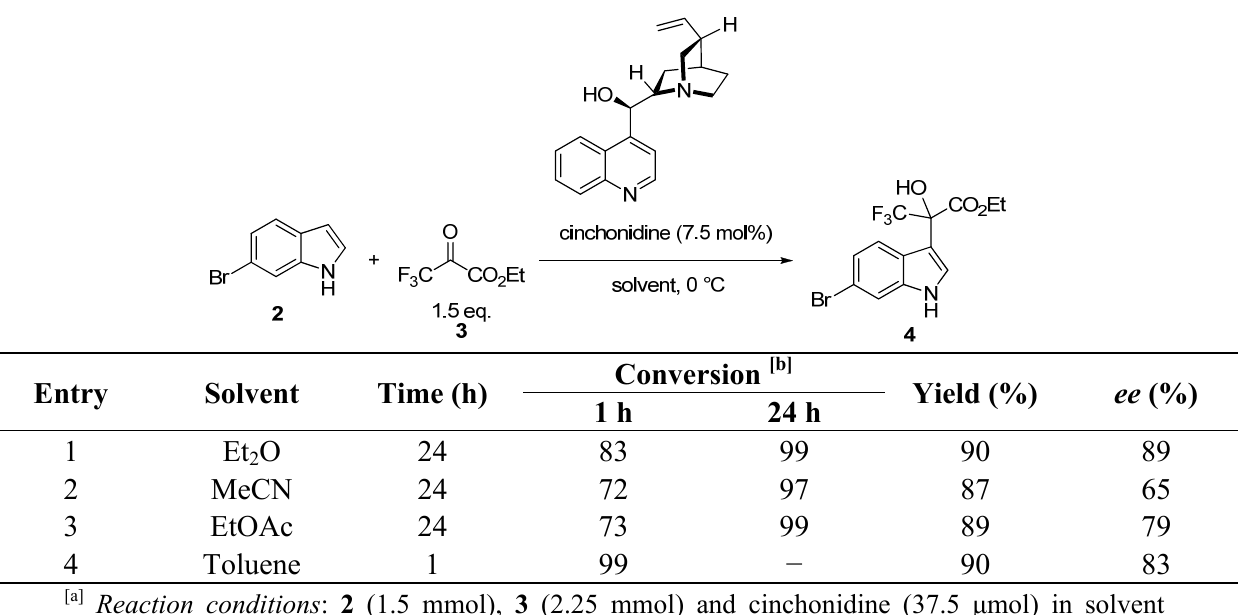
Table 1. Effects of solvents on cinchona alkaloids catalyzed asymmetric addition of 2 to 3 [a]